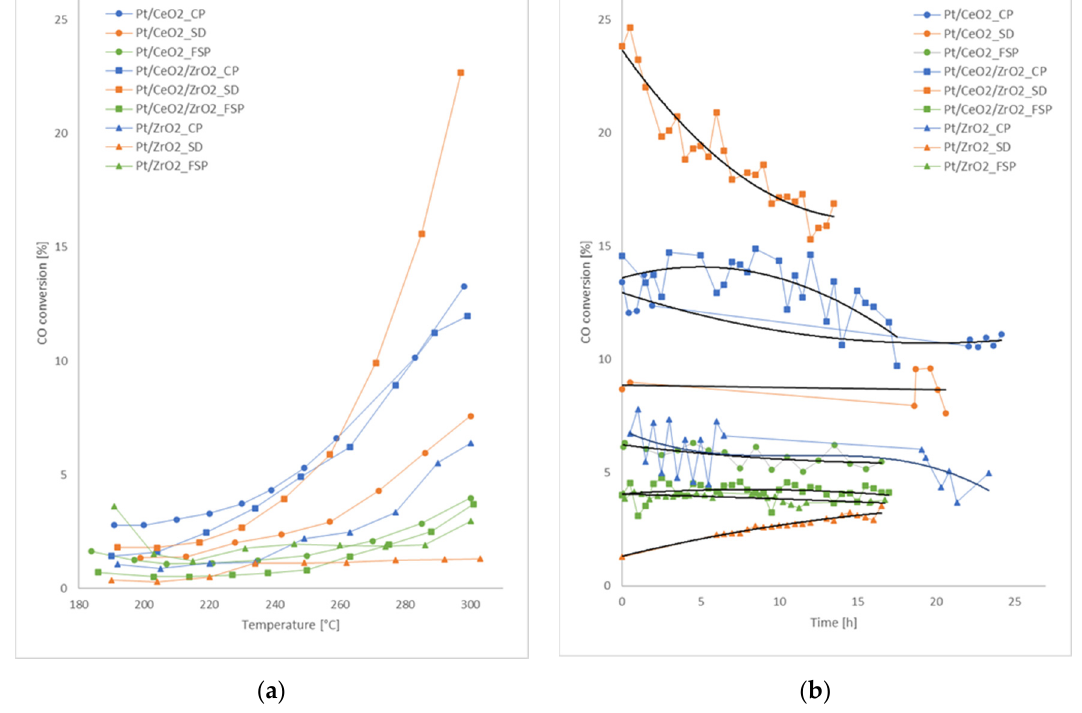
Figure 3. WGS activity as a function of ( a ) temperature and ( b ) time on stream at 300(310) °C. CP = coprecipitation/impregnation, SD = spray drying, FSP = flame spray pyrolysis.